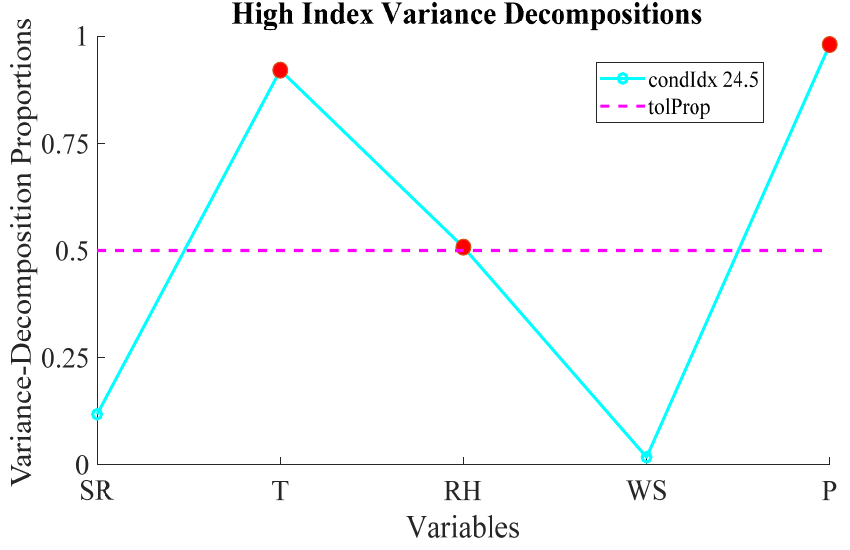
Figure 3. Collinearity test of the meteorological variables of Temixco.